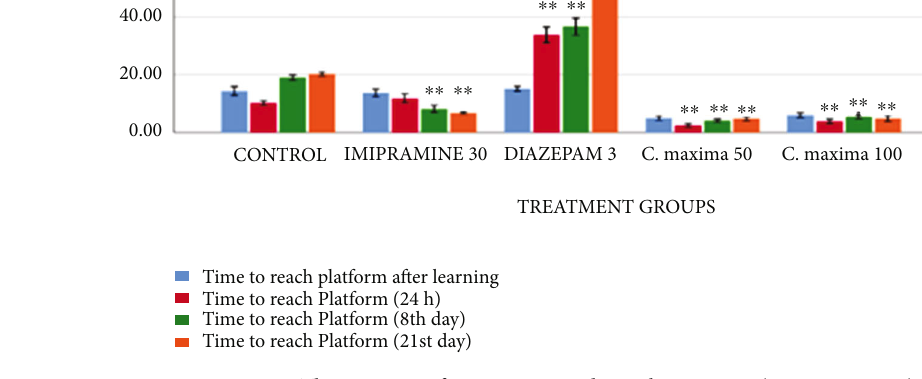
Figure 2: The outcome of C. maxima seeds on the memory (water maze test). Table 4: E ff ect of C. maxima seed extracts on motor coordination by rotarod. Groups and doses (mg/kg)